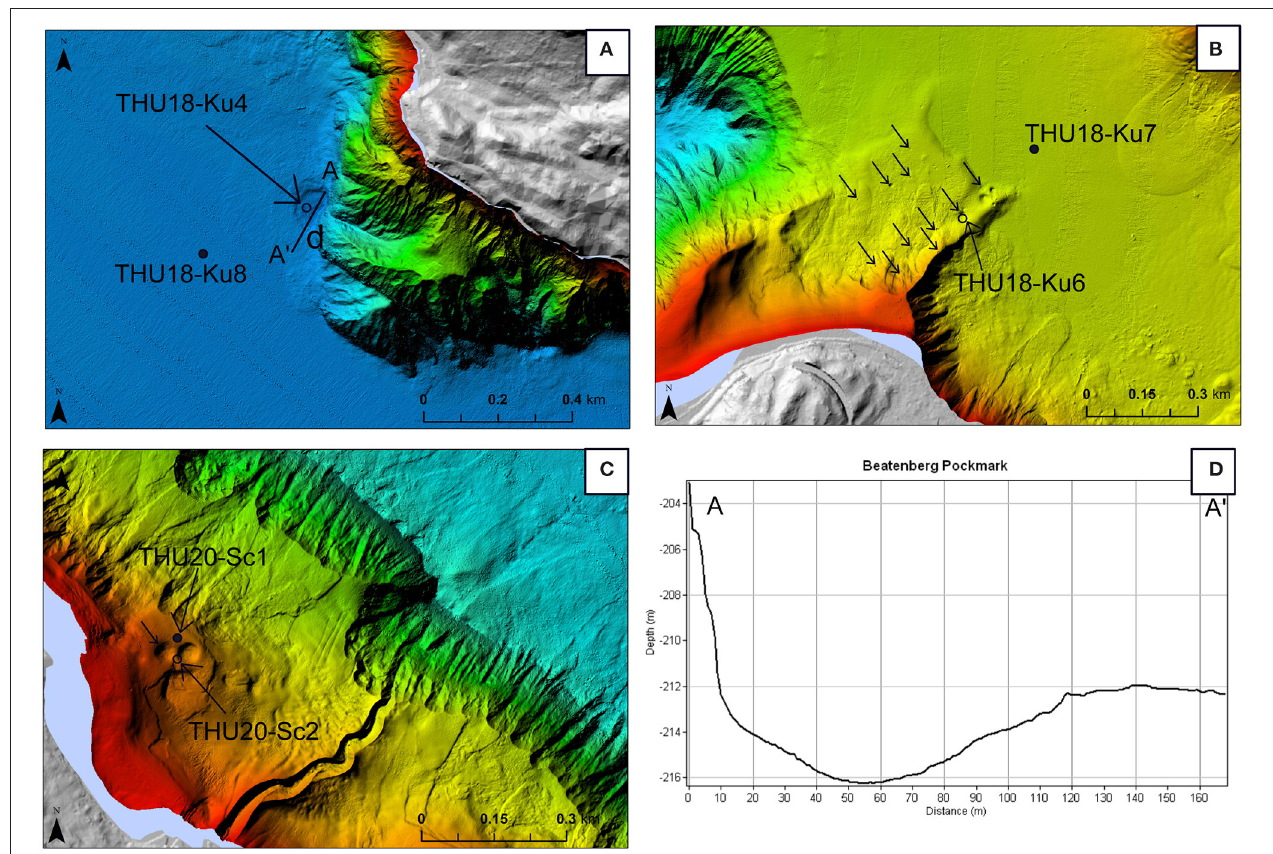
FIGURE 2 | Zoom-in of the bathymetric map ( Figure 1 ) showing the locations of the pockmark and reference cores sampled at BPS (A) , DPS (B) , and TPS (C) . (D) Shows a profile (A-A’) through the Beatenberg pockmarks, representing the deepest point of the lake. The arrows show the different pockmarks present on the lake bed at the three sites. The sampling positions at the reference and pockmark sites are represented by the black circles and dots,